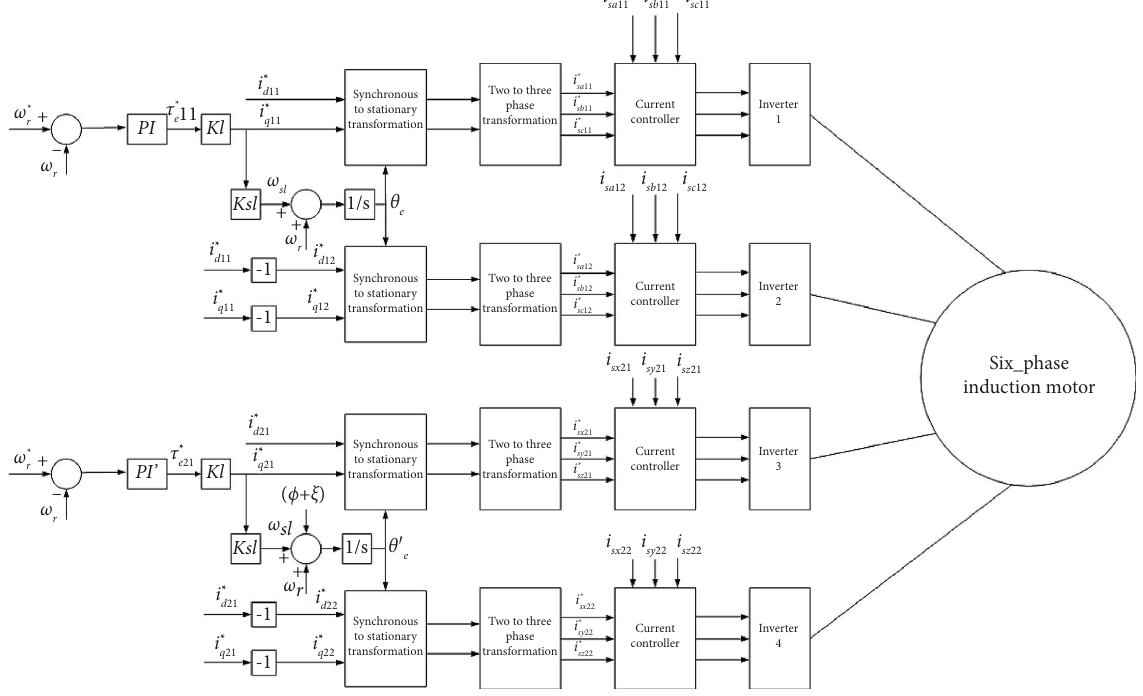
Figure 2: Block diagram of feld oriented open-ended asymmetrical six-phase induction machine.